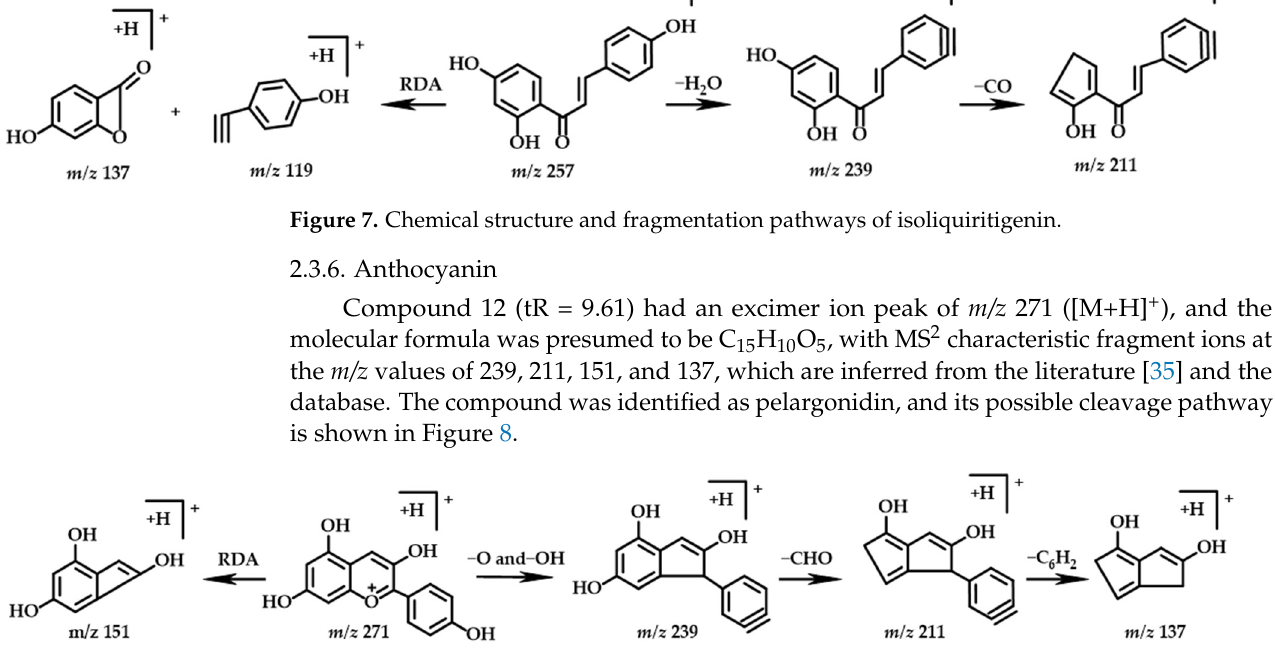
Figure 8. Chemical structure and fragmentation pathways of pelargonidin.